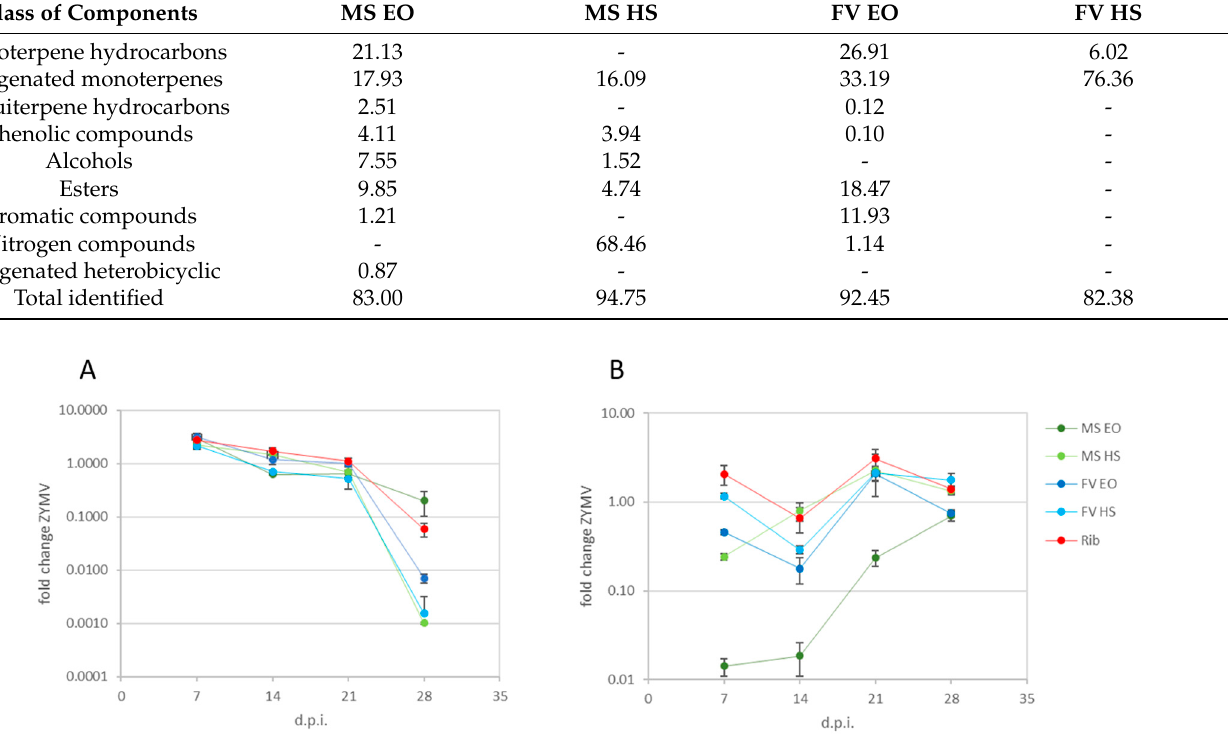
Figure 1. Fold changes of ZYMV in plants treated at the same time as inoculation ( A ) and treated after inoculation of ZYMV ( B ) on leaves harvested 7, 14, 21 and 28 d.p.i. MS EO = M. suaveolens essential oil; MS HS = M. suaveolens hydrosol; FV EO = F. vulgare essential oil; FV HS = F. vulgare hydrosol; Rib= ribavirin. Values are expressed as means of 2 technical replicates on 3 pooled biological replicates, and bars indicate standard error ( ±